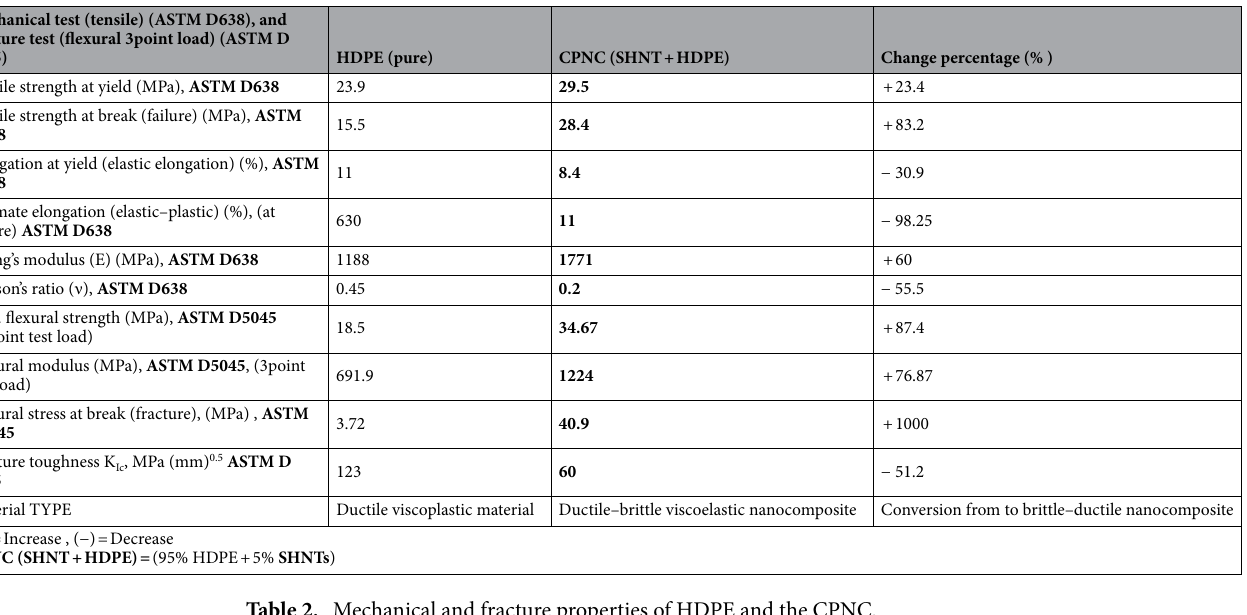
Table 2. Mechanical and fracture properties of HDPE and the